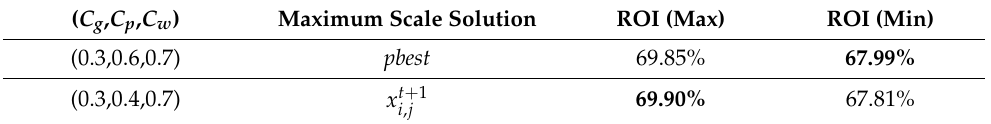
Table 8. Best and worst solutions under different parameter combinations (Experiment